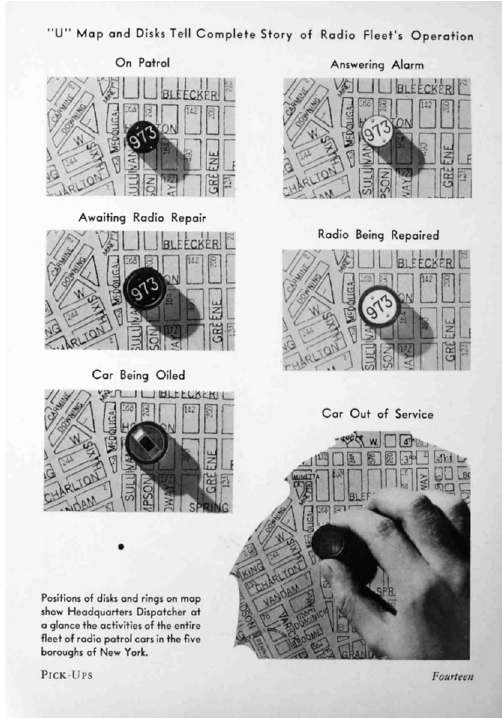
Figure 13. Thomas W. Rochester, “How New York Police Radio System Patrols 317 Square Mile Area”, Pick-Ups , February 1936. Image created by the author.